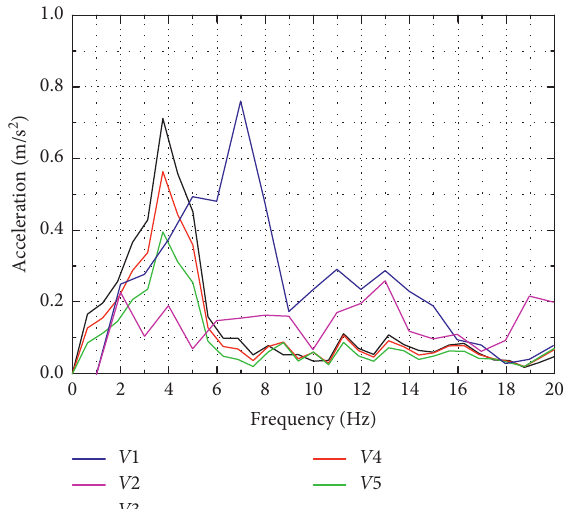
Figure 10: Spectra of measurement acceleration.